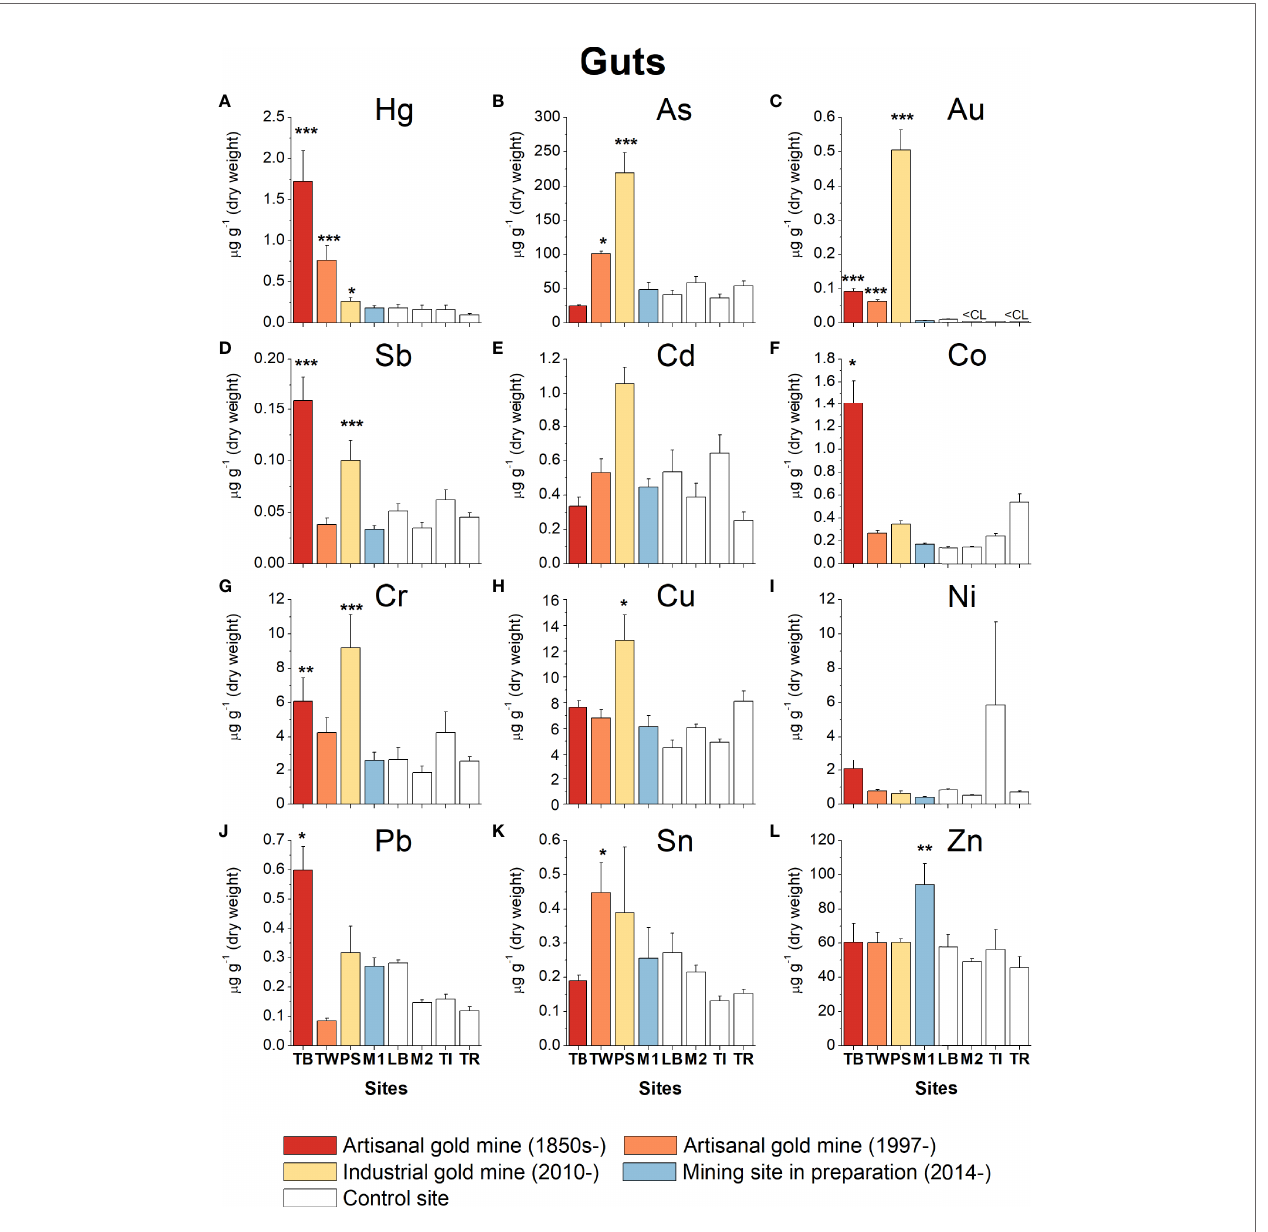
FIGURE 5 | Mean concentrations (± s.e.) in H. atra guts of Hg (A) , As (B) , Au (C) , Sb (D) , Cd (E) , Co (F) , Cr (G) , Cu (H) , Ni (I) , Pb (J) , Sn (K) and Zn (L) at each study site (TB, Totok Bay; TW, Talawaan River; PS, Pantai Surabaya; M1, West Bangka mangroves; LB, Lihunu Bay; M2, North-west Bangka mangroves; TI, Tumbak Island; TR, Tasik Ria Resort). Impact sites that differ signi fi cantly from controls are marked with asterisks: * p < 0.05; ** p < 0.01; *** p <